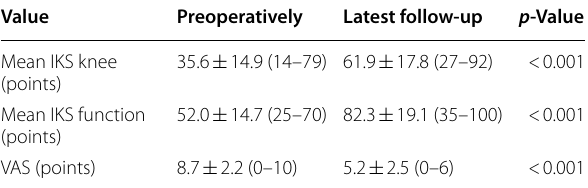
SD standard deviation, IKS international knee scores, VAS visual analog scale Paired t -test ( p <